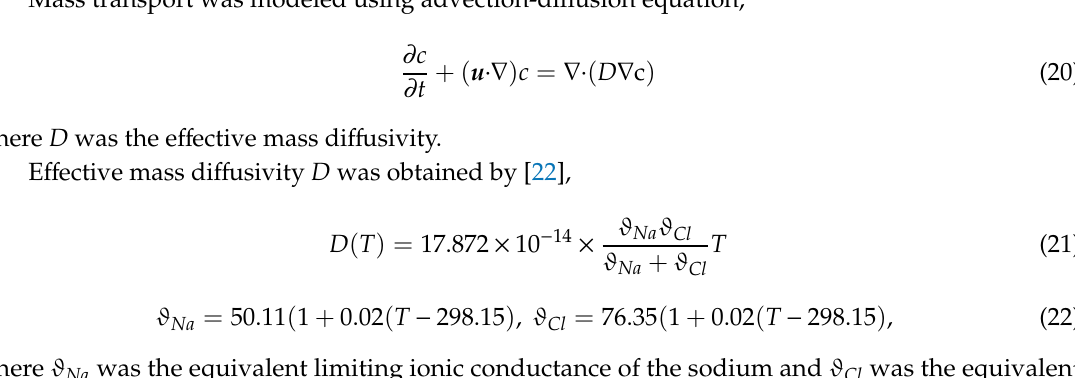
Figure 3. Model validation in different T f ( c f = 24.2 wt.%, left ; pure water, right ).